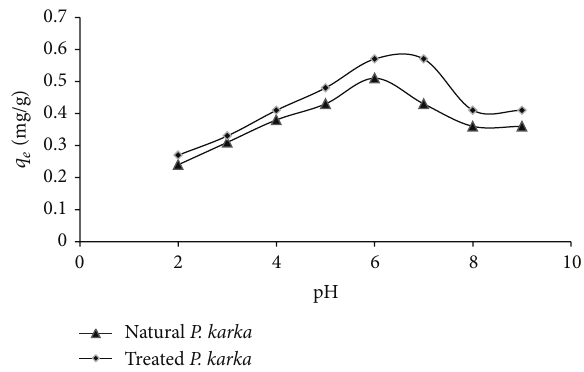
Figure 3: Effect of pH change on biosorption capacity of natural P. karka and treated P. karka (concentration = 10mg/L, time = 30 minutes, 𝑇 = 298 K, agitation speed = 150rpm, dose of biosorbent = 2 g/100mL, and pH = 2–8).